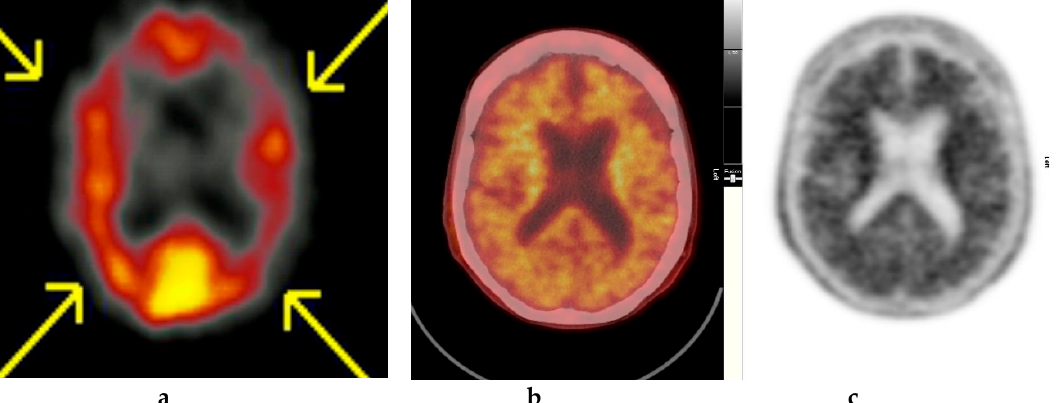
Figure 4. Abnormal study. Sixty-eight year old female patient with speech difficulties, deficits in memory, and visuospatial abilities. ( a ) [ 99m Tc]HMPAO-SPECT brain scan shows asymmetrical heterogenous reduced perfusion to both parietal and temporal lobes (worse on the left side) as with involvement of the frontal lobes identified by the yellow arrows. Normal areas of temporal perfusion were noted in between the abnormal parietal and frontal areas. In a patient with cognitive impairment, the findings indicate patterns of cerebral blood flow commonly seen in patients with mixed dementia,